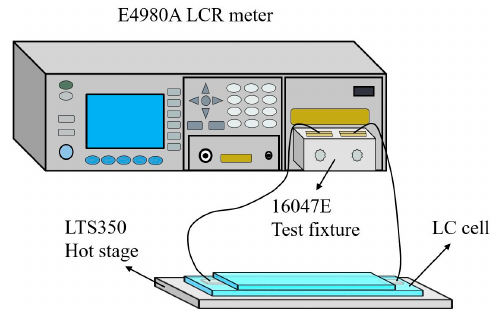
Figure 2. Experimental configuration for measuring the LC cell capacitance.